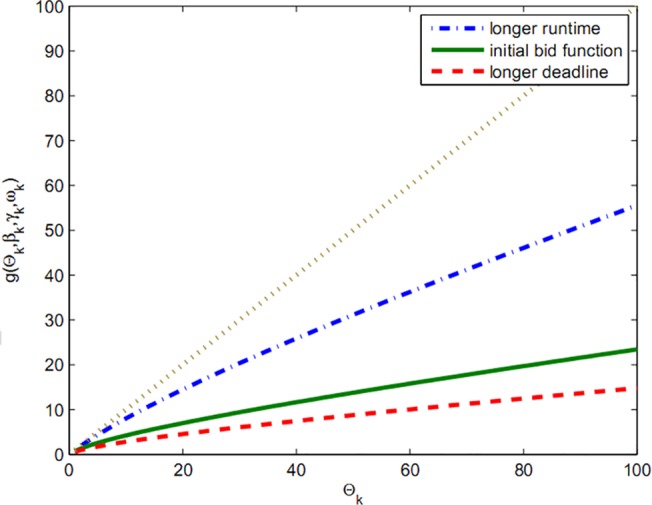
Bid with deadline.